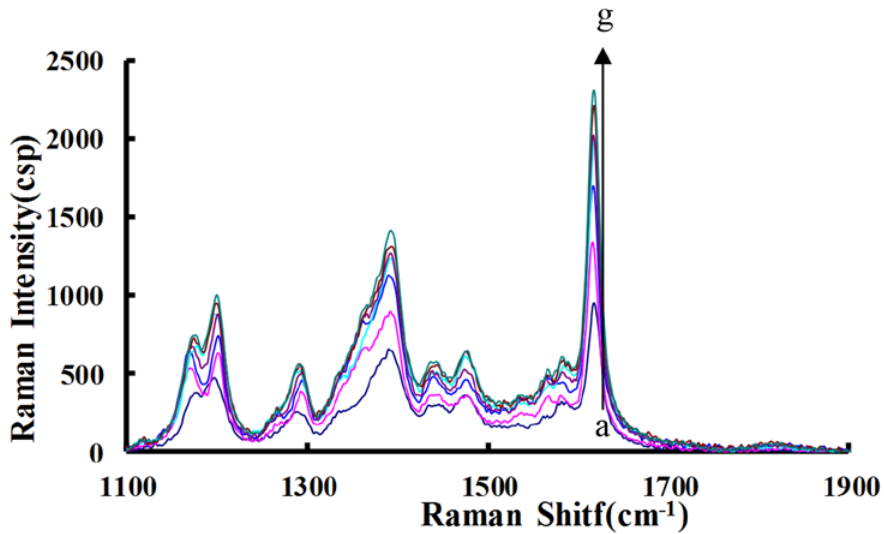
Figure 2. Surface-enhanced Raman scattering (SERS) spectra of HAuCl 4 -TSC-C 60 -Na 2 SO 4 -BaCl 2 -VBB system. a: 4.2 μM HAuCl 4 + 0.33 μM VBB + 0.33 mg/L C 60 + 170 μM TSC + 53 μM BaCl 2 ; b: a + 0.33 μM Na 2 SO 4 ; c: a + 0.67 μM Na 2 SO 4 ; d: a + 1 μM Na 2 SO 4 ; e: a + 1.33 μM Na 2 SO 4 ; f: a + 1.98 μM Na 2 SO 4 ; g: a + 2.31 μM Na 2 SO 4 .